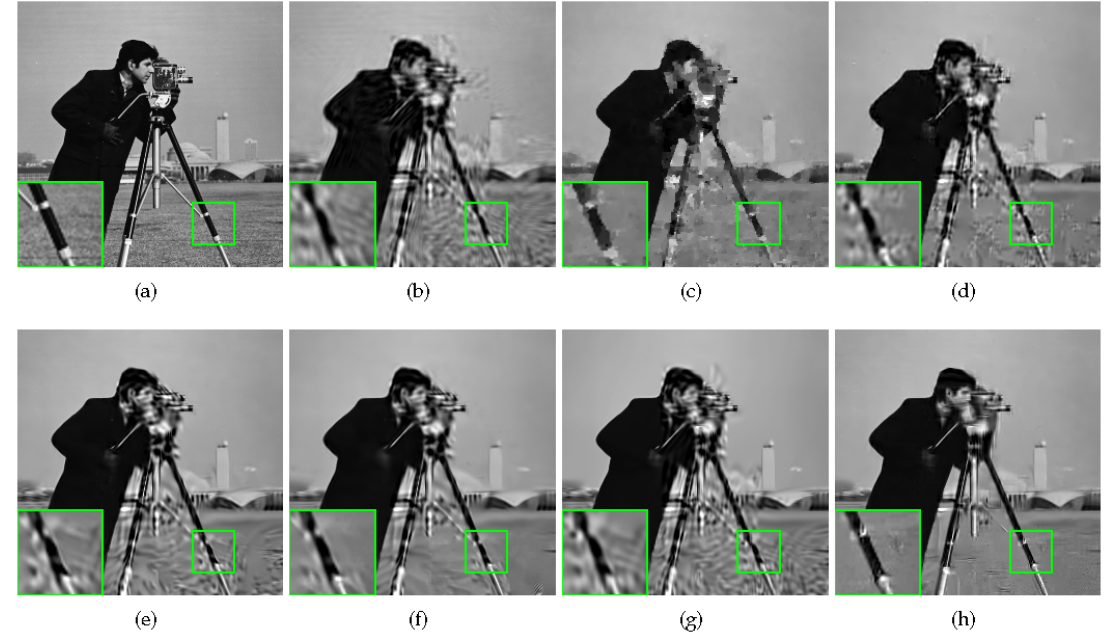
Figure 4. Reconstruction of Cameraman with sampling rate = 0.1. ( a ) Original image; ( b ) MH (PSNR = 22.13 dB, FSIM = 0.7692); ( c ) RCoS (PSNR = 22.97 dB, FSIM = 0.7942); ( d ) ALSB (PSNR = 22.97 dB, FSIM = 0.8021); ( e ) GSR (PSNR = 22.89 dB, FSIM = 0.8154); ( f ) JASR (PSNR = 23.54 dB, FSIM = 0.8139);